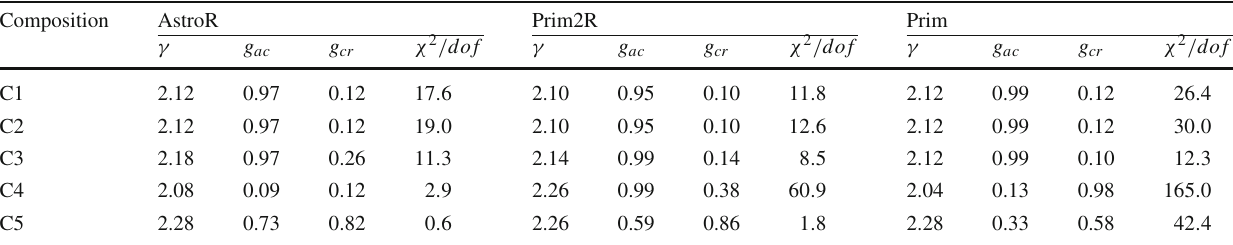
Fig. 3 Flux of UHECR as a function of energy. Dots show measurements done by the Pierre Auger Observatory [54]. Lines show the result of the fit as explained in Sect. 2.4. Three EGMF models (AstroR, Prim2R and Prim) and five composition abundances (C1–C5) are